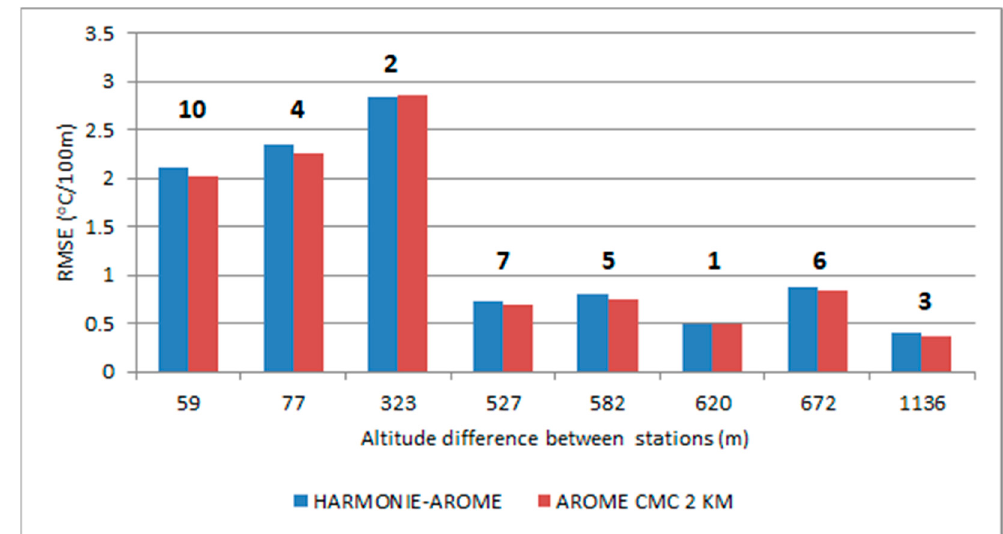
Figure 13. RMSE values for predicted temperature gradients for HARMONIE-AROME and AROME CMC 2 km.